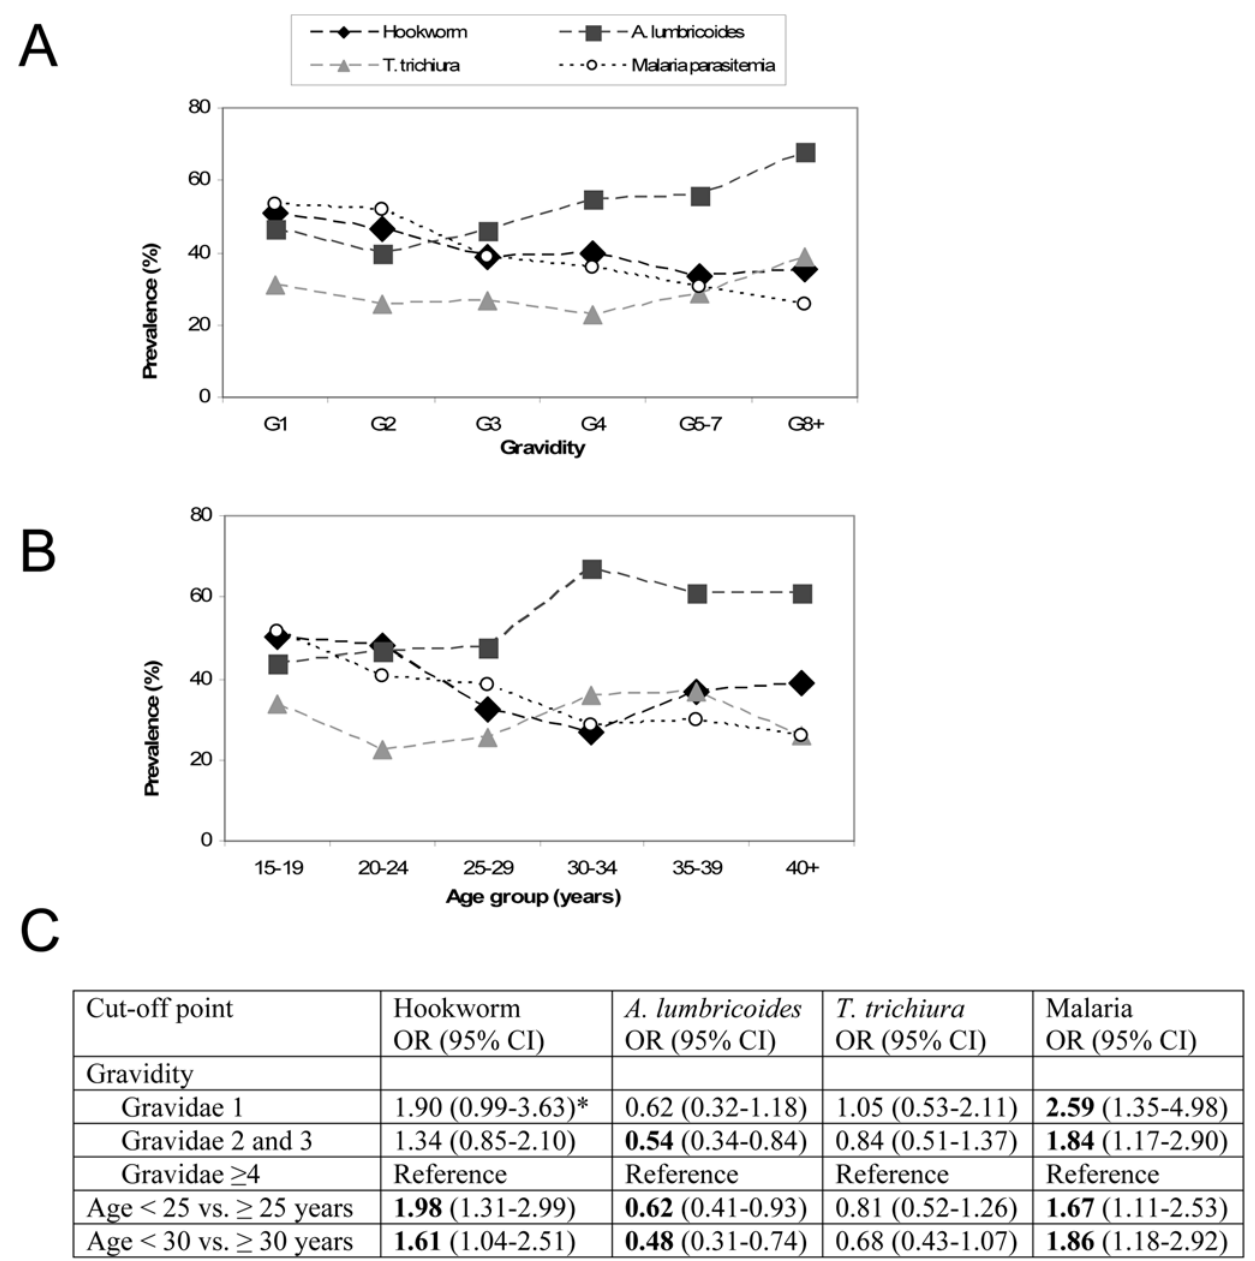
Figure 2. Prevalence of geohelminth infections and odds ratios by gravidity and age group among 390 pregnant women, Gem, July 2003. OR: odds ratio; CI: confidence interval. Significant odds ratios are printed in bold. Malaria parasitemia is presented for comparison. The cut-off points for age and gravidity were obtained from visual inspection of the graphs above. * P =0.05.